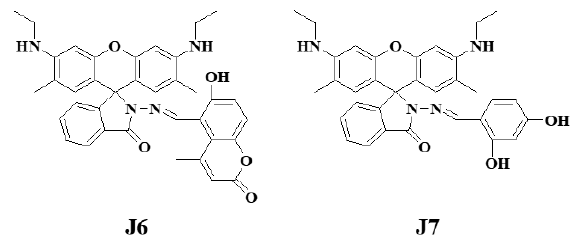
Figure 1. Structures of J6 and J7.